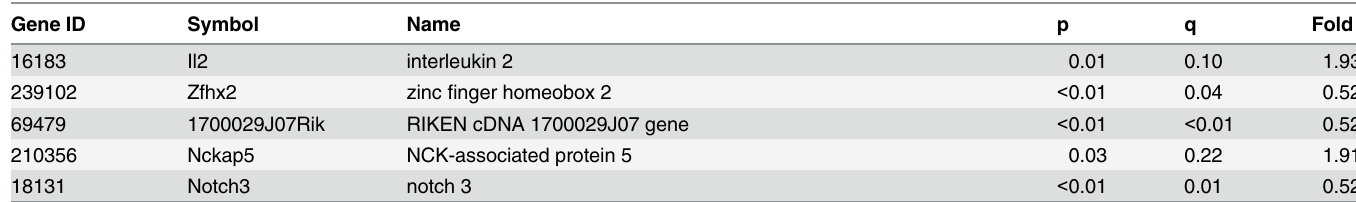
S2 Table. Location of binding overlaps the annotated region unless otherwise noted, in which case the reported gene is the nearest annotated gene; we have indicated those in Table 2 and S2 Table. Various transcripts of protein coding genes, pseudogenes, lincRNA genes, miRNA genes, snoRNA genes and unclassified genes were found to physically interact with HuR by HuR RIP-Seq. The top significant HuR associated transcripts and the number of HuR hits are dis- played in Table 2. Many of those transcripts are novel HuR target genes which have been shown to play pivotal roles in CD4 + T cell activation and Th2 differentiation. We validated HuR RIP-Seq data by performing HuR RIP followed by RT-qPCR in some of potential HuR transcripts in Th2 polarized CD4 + T cells. IL-2, CAMK2 and CAMK4 transcript enrichment in RIP using HuR antibody were analyzed as compared to RIP using IgG1 antibody. In agreement with the HuR RIP-Seq data, IL-2 and CAMK4 were found to be direct HuR target transcripts while CAMK2 did not seem to be an appreciable direct HuR target transcript (S2A Fig).